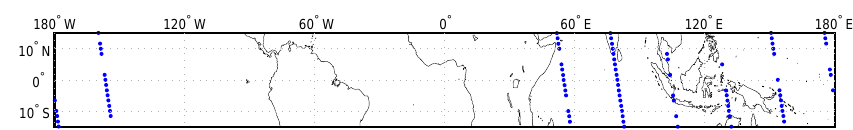
Fig. 1. Aura TES nadir orbit for 9 December 2006 during daytime over 15 ◦ S to 15 ◦ N. Only the 85 high quality HDO retrievals are shown, of 133 in total.